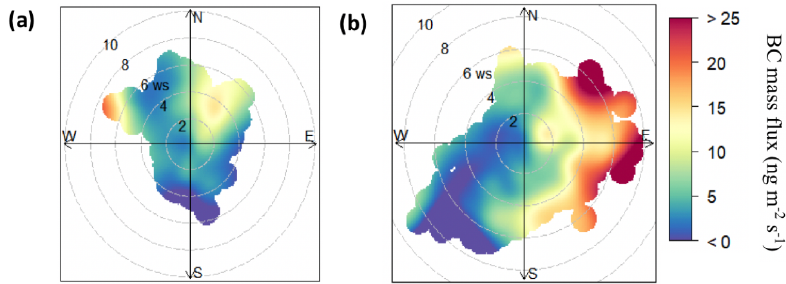
Figure 9. BC mass flux distribution by wind direction and wind speed for the (a) winter and (b) summer analysis done using OpenAir software (Carslaw and Ropkins, 2012).